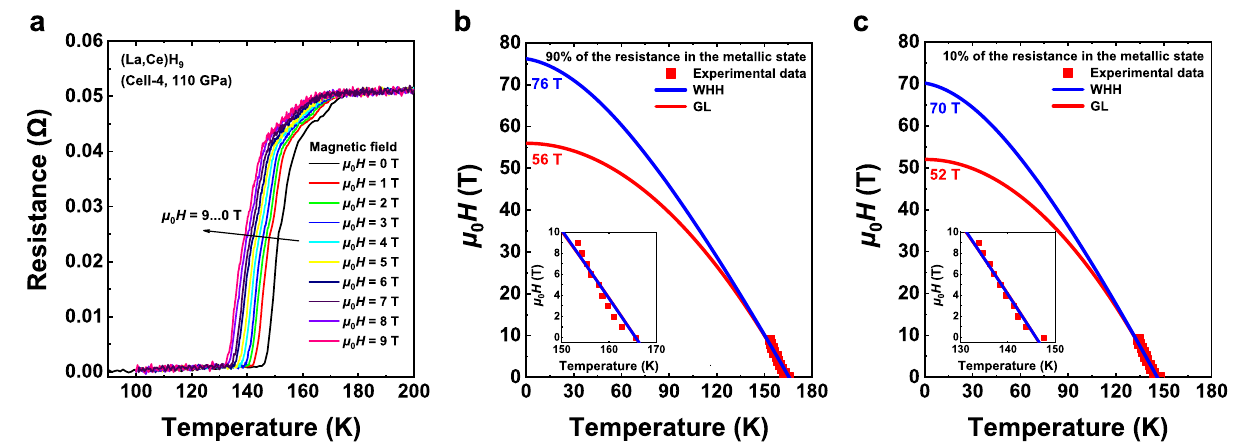
Fig. 5 | Electrical measurements in the external magnetic fi eld of the synthe- sized (La,Ce)H 9 . a Temperature dependence of the electrical resistance under applied magnetic fi eldsof μ 0 H =0 – 9Tat110GPa. b and c Uppercritical fi eld μ 0 H c2